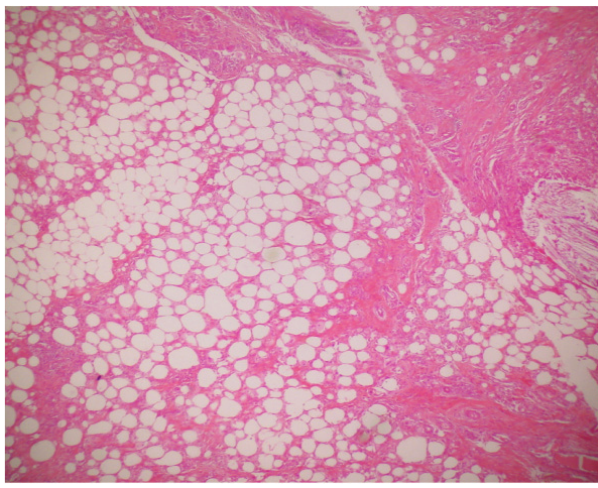
Figure 6 - Photomicrograph showing adipocytes without cellular atypia (hematoxylin and eosin, 200